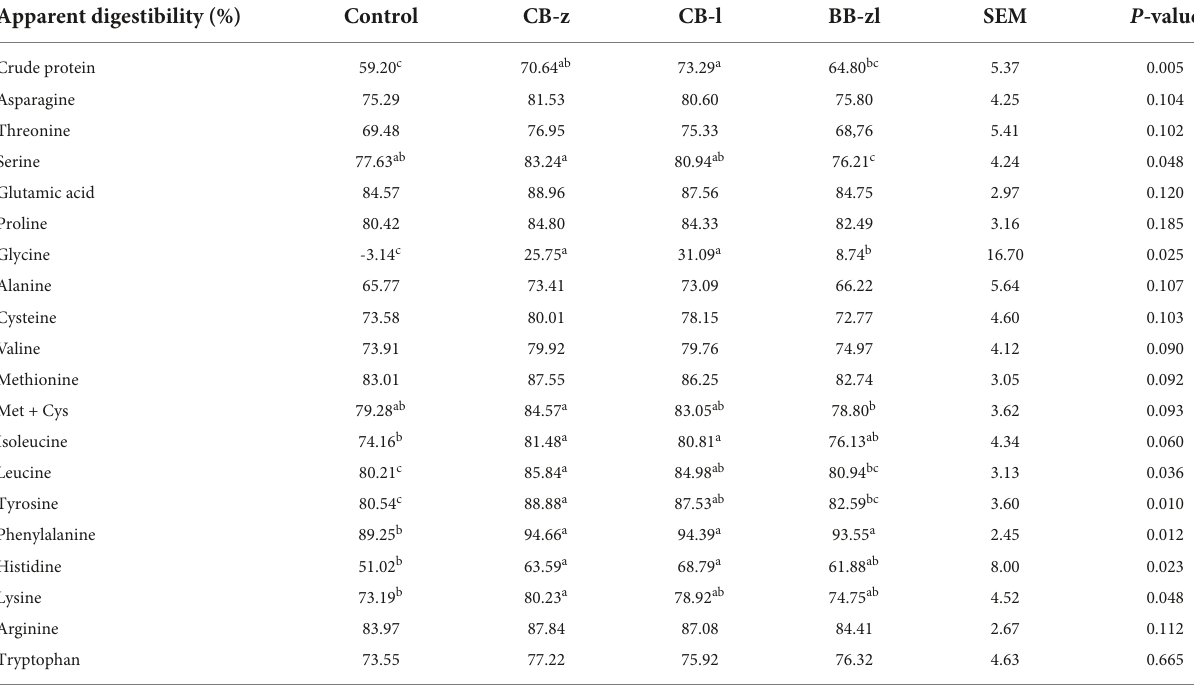
TABLE 6 Effects of Clostridium butyricum and Brevibacillus sp. on the apparent fecal amino acid digestibility coefficient of laying hens.